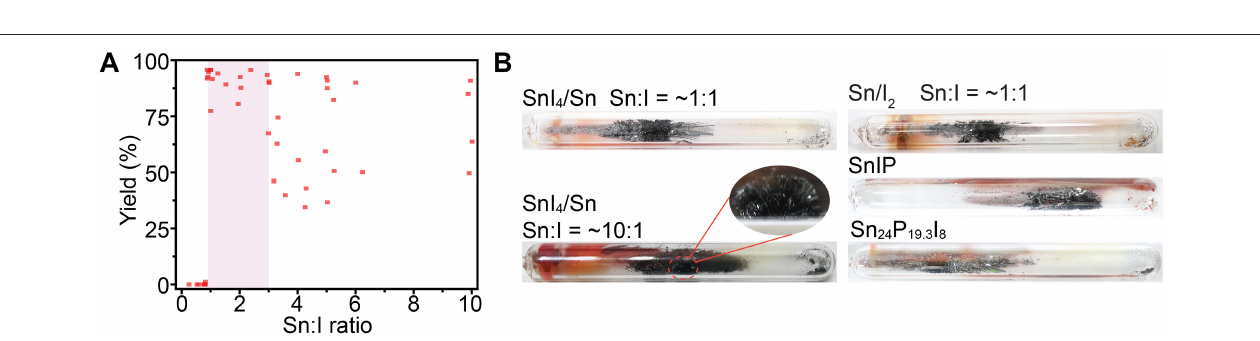
FIGURE 1 | (A) Photo of the as-prepared bulk BP crystals. (B) SEM image showing the layered structure of the BP crystal. (C) Schematic illustrations of the atomic structure of orthorhombic BP and corresponding vibrational modes in Raman spectroscopy. (D) Powder XRD pattern of the obtained BP crystals. Inset: schematic illustration of a crystal cell of orthorhombic BP and its crystal planes. (E) Raman spectrum of the as-prepared BP.